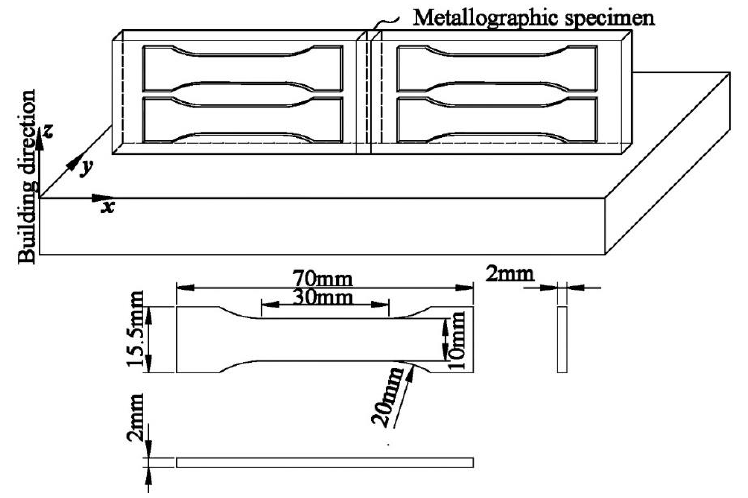
Figure 4. Schematic diagram of metallographic specimens and mechanical test specimens in as-deposited walls.